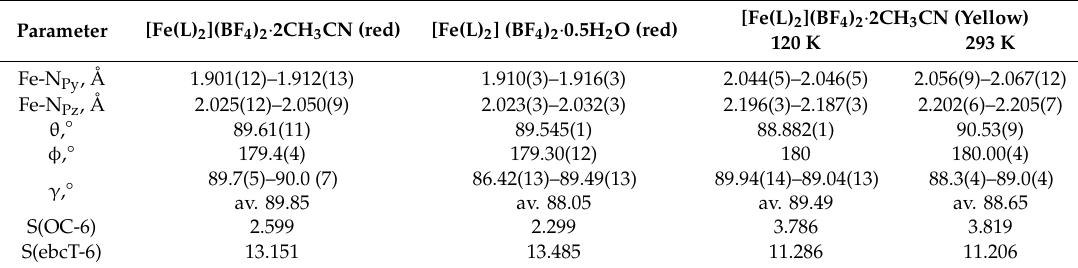
Table 2. Main geometric parameters 1 and continuous symmetry measures 1 as obtained